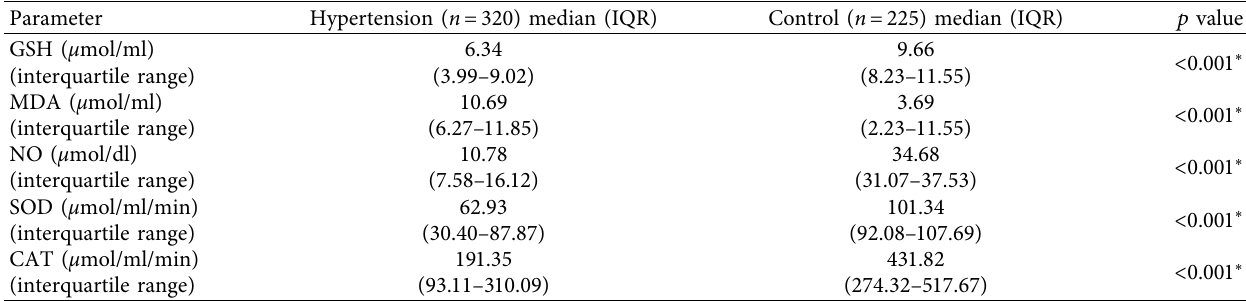
Table 3: Biomarkers of oxidative stress and endothelial function of hypertensive and control volunteers.